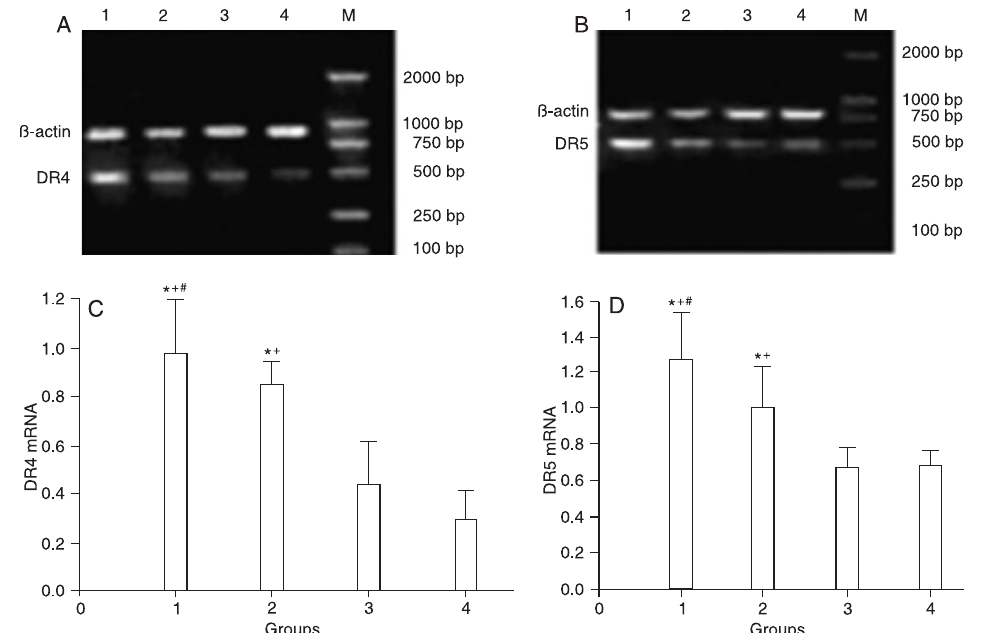
Figure 6. Effect of TRAIL and/or ADM on DR4 and DR5 mRNA expression in MCF-7 cells. Panels A and C, DR4 mRNA; panels B and D , DR5 mRNA. MCF-7 cells were treated with TRAIL (0.1 µg/mL) and/or ADM (0.5 µg/mL) for 24 h and the changes of DR4 and DR5 in mRNA levels were determined by RT-PCR. β-actin was used as internal control. Lane M , DL2000; lane 1 , combination group; lane 2 , ADM alone group; lane 3 , TRAIL alone group; lane 4 , negative control group. TRAIL = tumor necrosis factor-related apoptosis-inducing ligand; ADM = adriamycin. * P < 0.05 compared to negative control group; + P < 0.05 compared to the TRAIL alone group; # P < 0.05 compared to the ADM alone group (Student t -test).